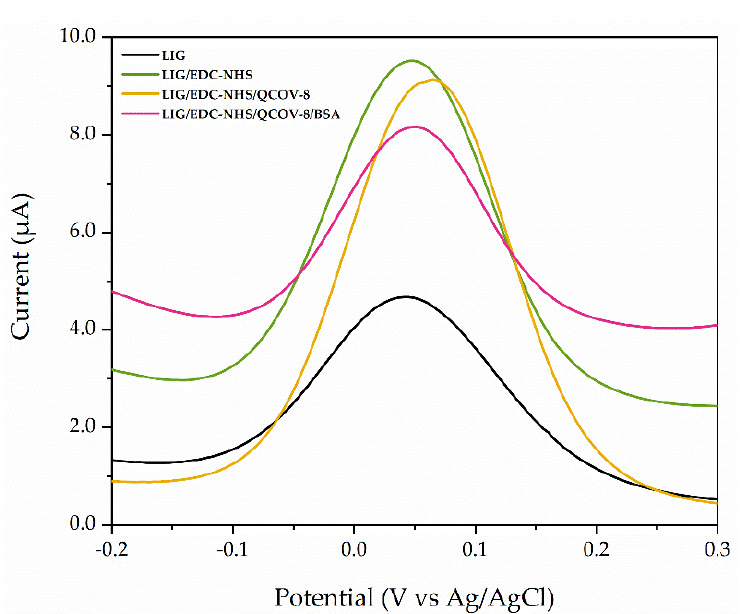
Figure 5. Differential pulse voltammograms in the presence of a K 4 [Fe (CN) 6 ] redox pair evaluating the electrode functionalization steps.